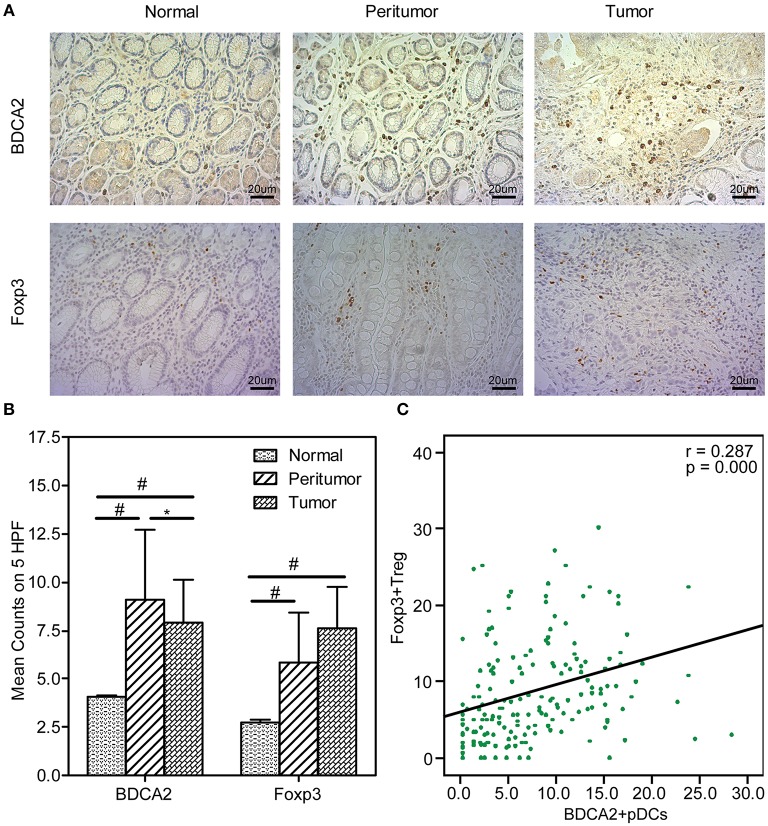
Increased BDCA2+pDCs and Foxp3+Tregs in tumoral and peritumoral tissues. Representative immunohistochemical (IHC) staining of BDCA2 and Foxp3 in tumoral, peritumoral, and normal gastric tissue are shown (magnification, × 400) (A). Box plot set showing the BDCA2+pDCs and Foxp3+Treg cell level in different tissues. Independent t-tests were used to analyze variation among the three stomach microhabitats. #p < 0.01 when compared normal group with peritumoral and tumoral groups; *p < 0.05 when compared peritumoral group with tumoral groups (B). The presence of BDCA2+pDCs was positively correlated with the increased number of Foxp3+Tregs in stomach tissues (C).